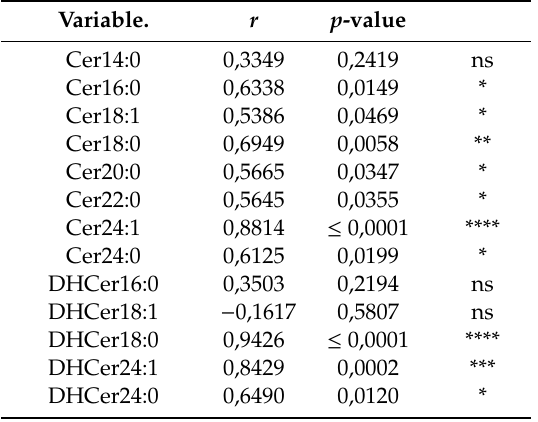
Figure 7. Linear regression graphs showing the correlation between the rate of MIB-1 staining and single ceramides and dihydroceramides species. *, p ≤ 0.05; **, p ≤ 0.01; ***, p ≤ 0.001, ****, p ≤ 0.0001. Table 1. Summary of the correlation analysis between ceramides and MIB-1. *, p ≤ 0.05; **, p ≤ 0.01; ***, p ≤ 0.001, ****, p ≤ 0.0001